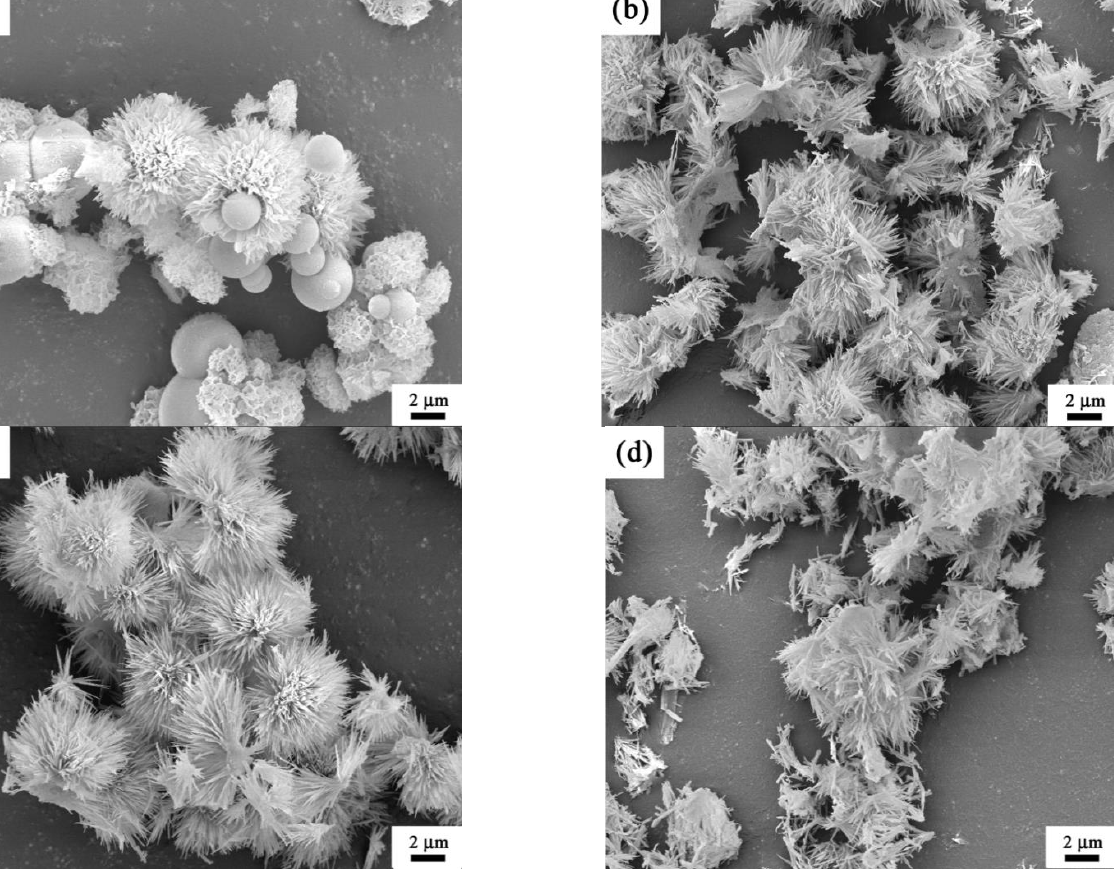
Figure 4. SEM micrographs of annealed powders transformed from the precursors prepared by the hydrothermal method under the different molar ratio of Al 3+ :CO(NH 2 ) 2 : ( a ) 1:3, ( b ) 1:5, ( c ) 1:6 and ( d ) 1:7.